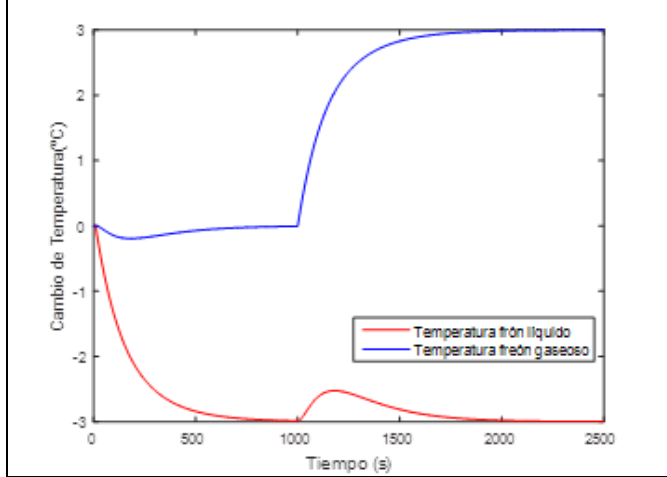
Figura 7: Respuesta del sistema multivariable con controladores de Síntesis Directa. Fuente: Los autores, 2018.